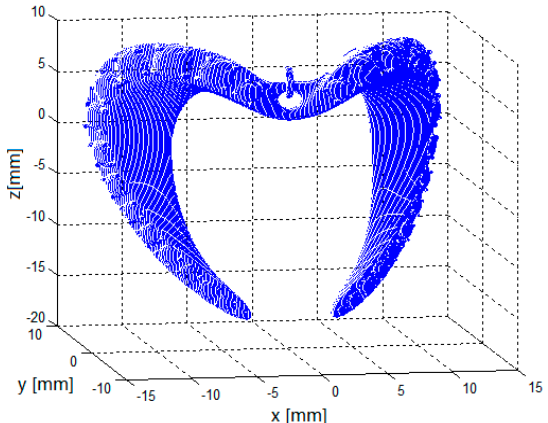
Figure 10. The tested complex surface model: jewelry.